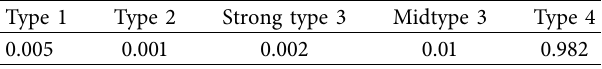
Table 1: Percentage of clone types in